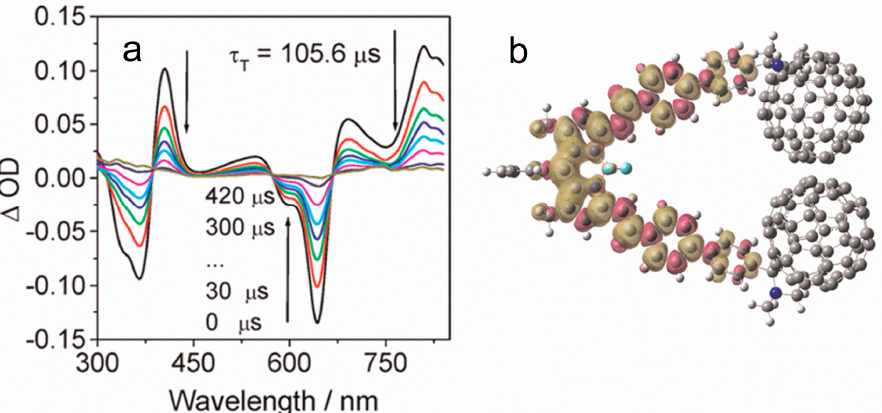
Figure 17. ( a ) Nanosecond transient absorption spectra of styrylBDP-C 60 -1 (color lines: ns-TA spectra at different time). In deaerated toluene, λ ex = 532 nm, 20 °C. ( b ) Spin density surface of the T 1 state of the styrylBDP-C 60 -1. Calculated at the B3LYP/6-31G(d) level with Gaussian 09. Reproduced with permission from reference [83], copyright 2012, American Chemical Society.